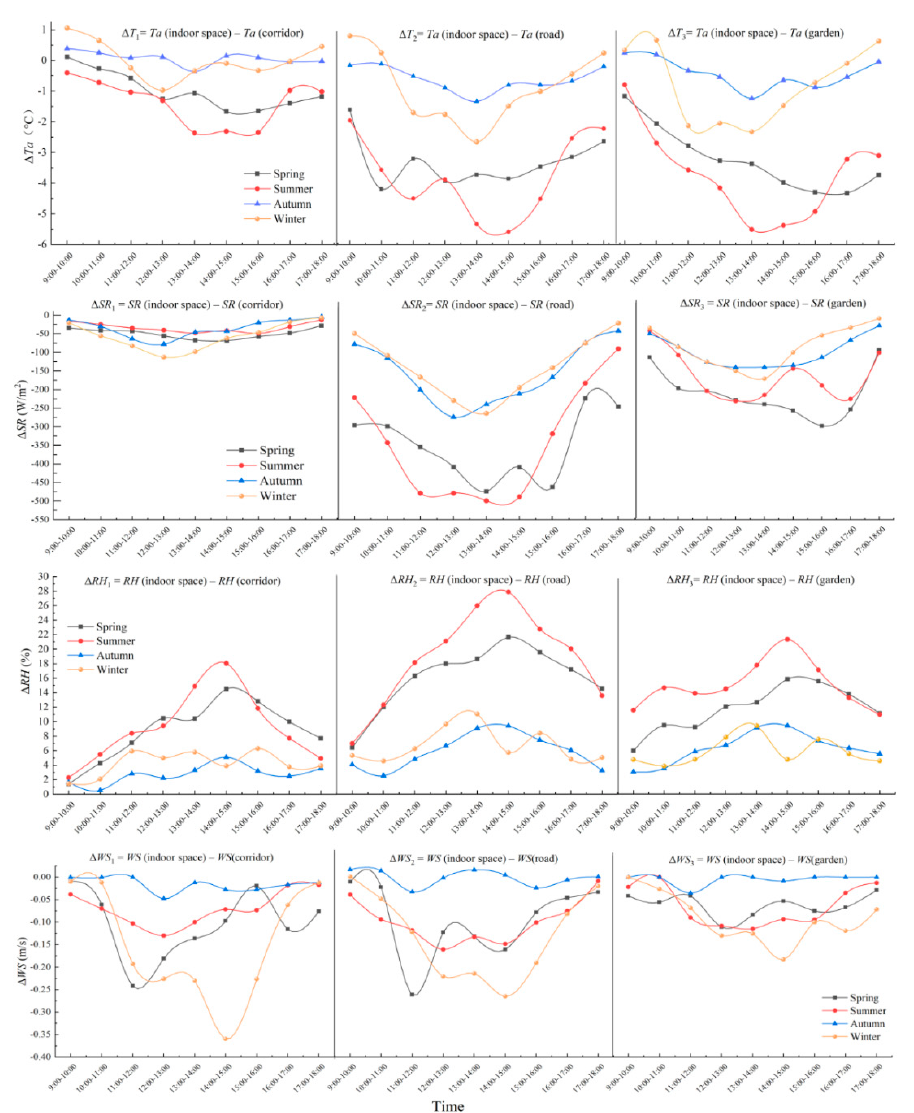
Figure 6. The seasonal microclimatic differences of indoor and outdoor spaces. ( a ) T a ; ( b )SR; ( c )RH; ( d ) WS.